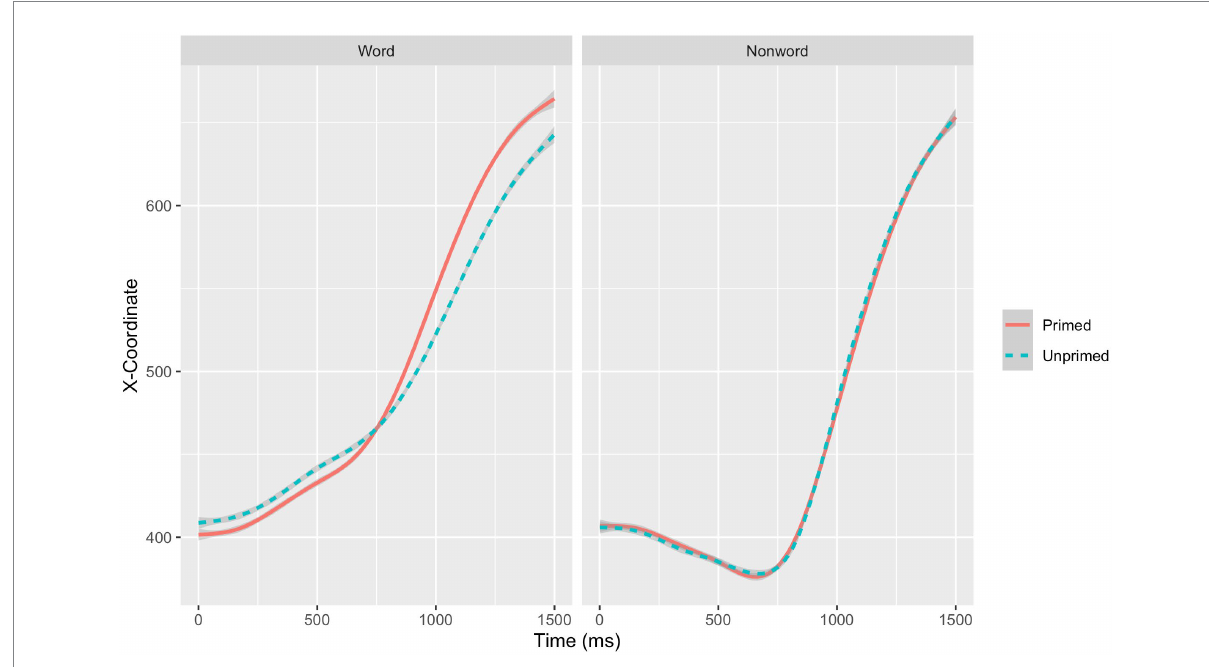
FIGURE 2 The initial 1,500 ms in Experiment 2 of the mouse trajectories for primed and unprimed words and